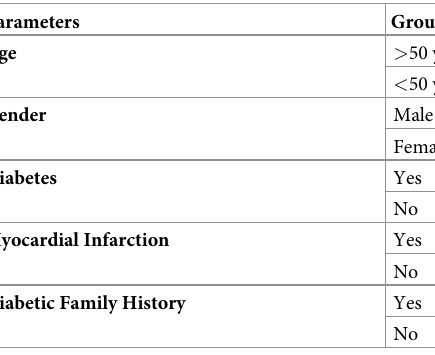
Table 3. Demographic data of